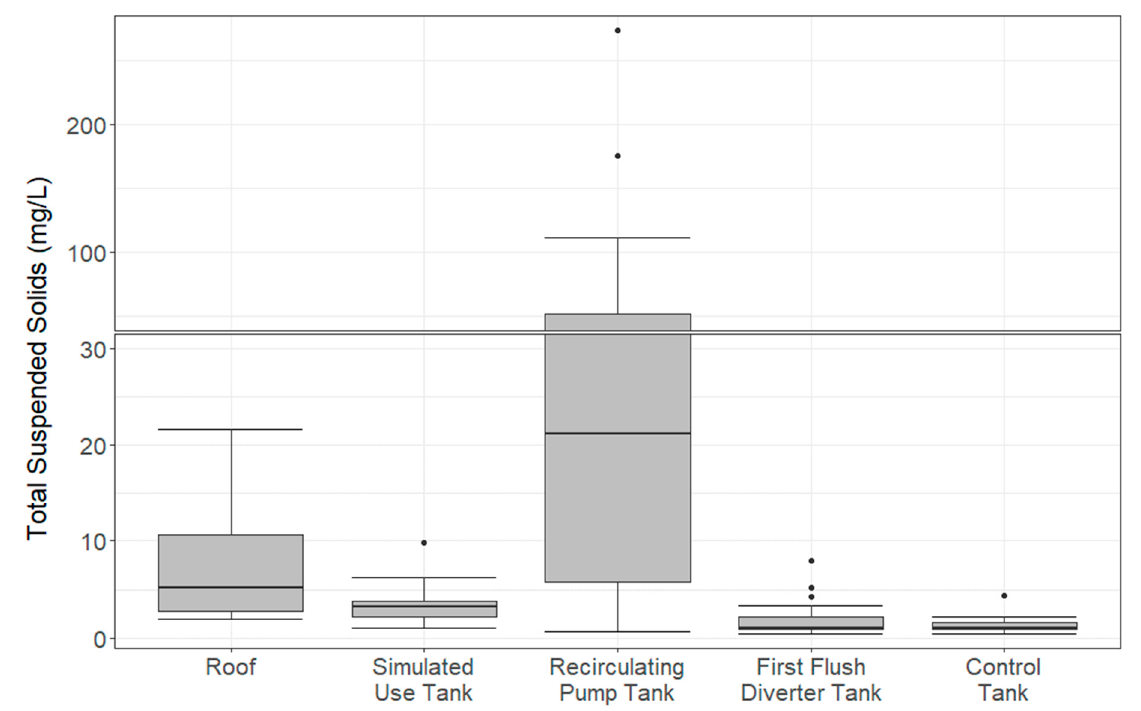
Figure 7. TSS concentrations for roof runoff and rainwater tank samples (note the y-axis break at 35 mg/L). Black dots represent outliers (defined as values greater than or less than 1.5 * inner quartile range).